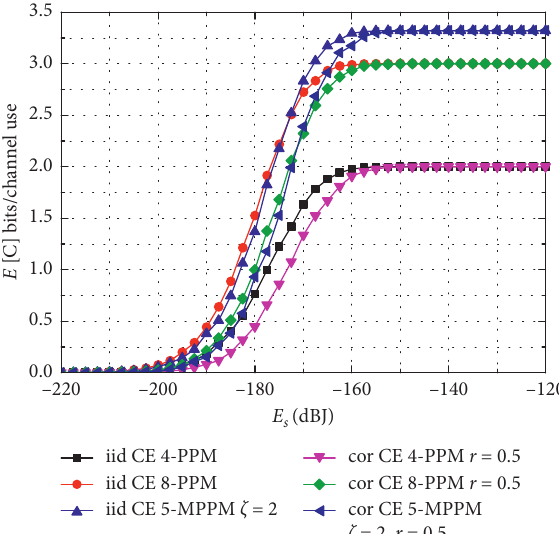
Figure 7: Ergodic channel capacity of different modulation methods in a 2 × 2 MIMO